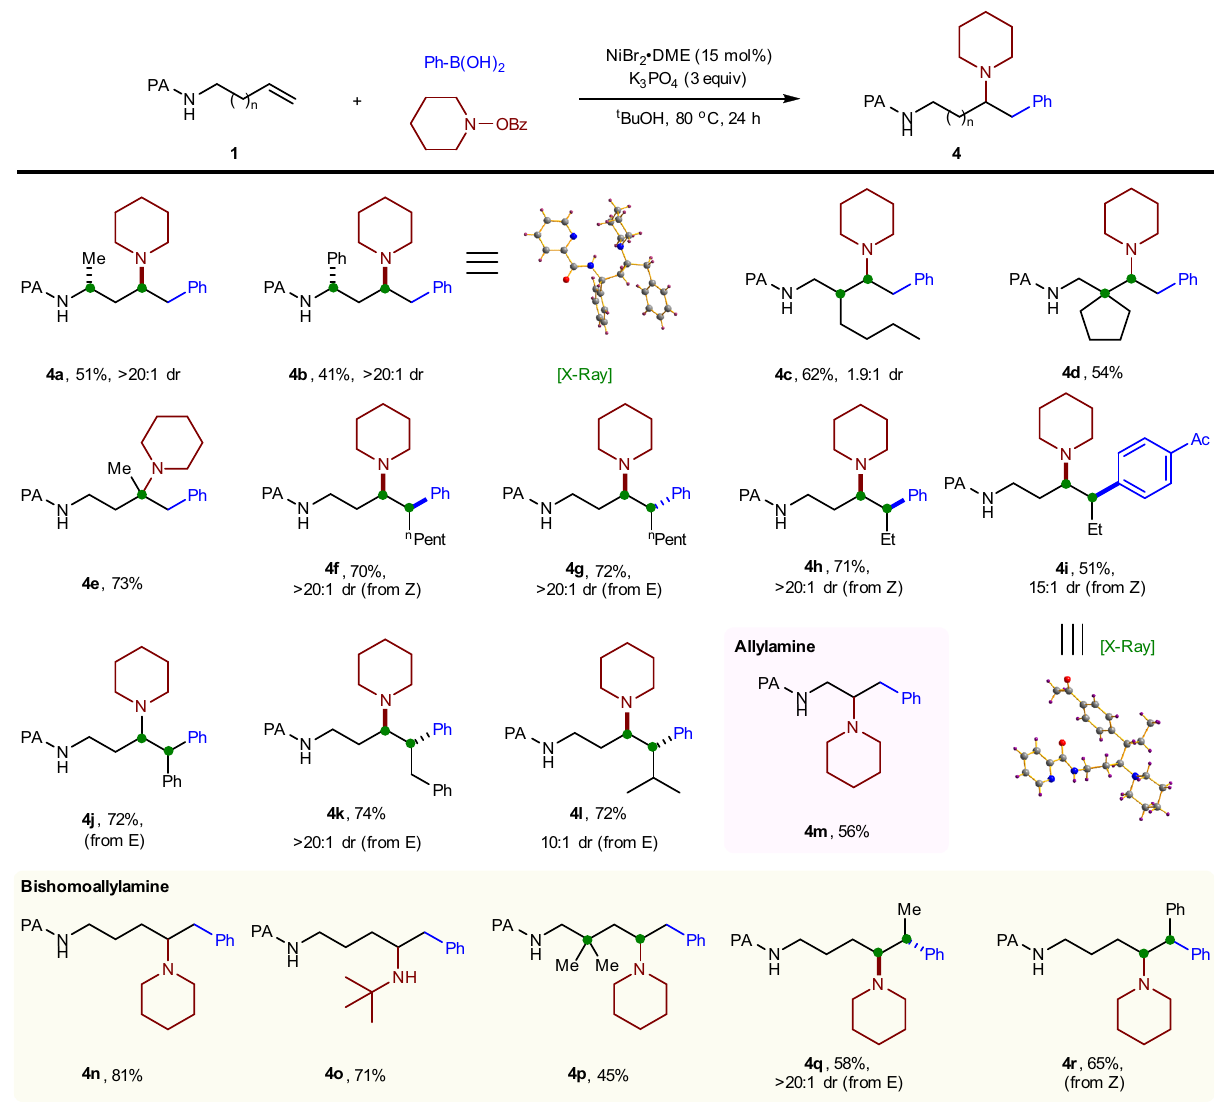
Fig. 5 Scope of alkenes. Reactions conditions: 1 (0.2 mmol), ArB(OH) 2 (3 eq), N – O reagent (2 eq), t BuOH (2 mL); dr was determined by NMR or GC-MS analysis of the crude